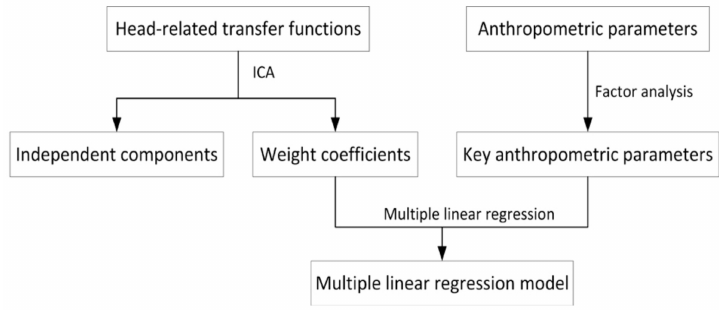
Figure 1. Workflow of the hybrid